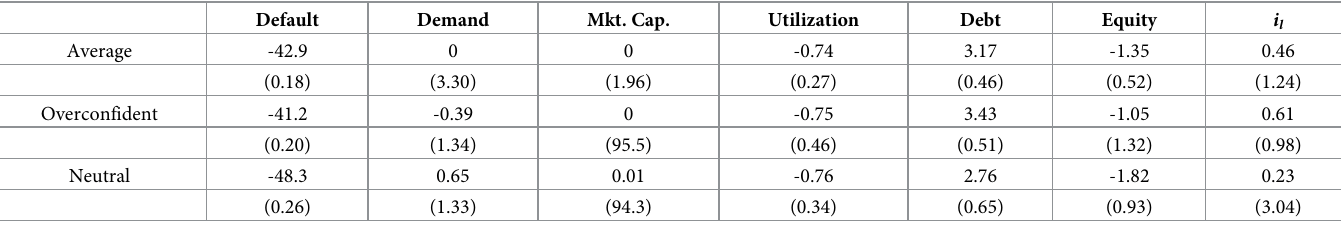
Table 5. Shock on parameters λ d , min and λ d , max